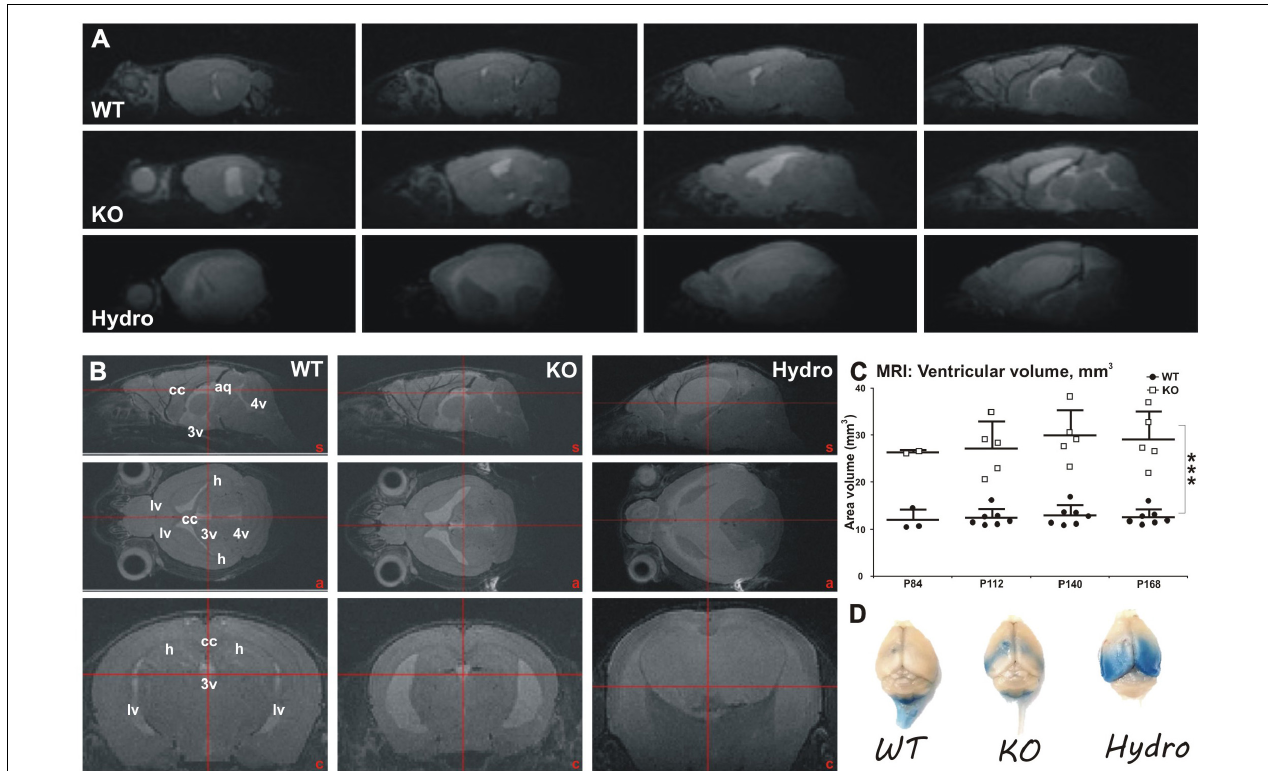
FIGURE 6 | Longitudinal MRI analysis of ventricular volume in WT and MIM KO mice. (A) Representative sagittal sections throughout the brain of WT, MIM KO (KO), and MIM KO hydrocephalic (Hydro) mice. (B) Sagittal (top row), axial (middle row) and coronal (bottom row) reconstructed T2-weighted MRI images showing parenchyma water content and ventricular size range in WT, MIM KO, and MIM KO hydrocephalic (hydro) mice. An increment in water content and in ventricle size is evident in MIM KO transgenic mice. A distinctive severe condition is apparent in male MIM KO mice, where 2 out of 3 analyzed subjects show a clear hydrocephalic condition (Hydro). (C) Longitudinal measurement of ventricular volume in WT ( n = 7) and MIM KO ( n = 5) mice between post-natal days P84 and P168. Note that at P84 day only two MIM KO and three WT mice have been analyzed; moreover, the two hydrocephalic male mice have been excluded from the analysis of ventricle volumes at all time points. Ventricular volume was measured drawing the regions of interest (ROIs) in lateral (lv), third (3v) and fourth (4v) ventricles, and in cerebral aqueduct (aq). The ventricular volume is increased in MIM KO compared to WT mice already at day P84 and progress over time. Scatter dot plot of data with mean ± SEM are presented. ∗ denotes statistical significance: ∗∗∗ p < 0.001. (D) Exemplificative macro photographs of WT, MIM KO and hydrocephalic mouse brains 2 h following Evans Blue (EB) injection in the left ventricle. Tracer distribution and putative clearance are altered in MIM KO and hydrocephalic mice, as highlighted by the accumulation of EB in the ventricles and periventricular areas in MIM KO mice. However, no tracer leakage outside the ventricles was observed in MIM KO non-hydrocephalic